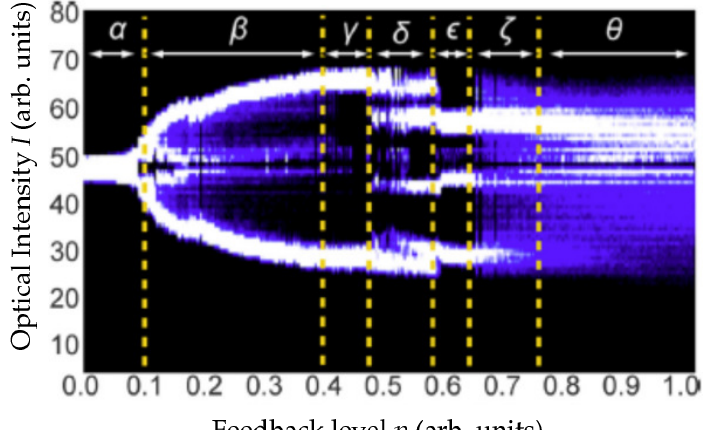
Figure 4. Experimental bifurcation diagrams of a Mitsubishi ML925B11F diode with J = 2.28 J th and L = 30cm. Greek letters indicate regions of existence of various dynamical regimes. α : CW; β : quasiperiodic-like (QP); γ : limit cycles (LC); δ : multistate intermittency including subharmonic (SH) behavior, ε : period-doubled (PD), ζ : intermittency between PD and coherence collapse (CC), θ : CC. Reproduced from Ref. [24], with the permission of AIP